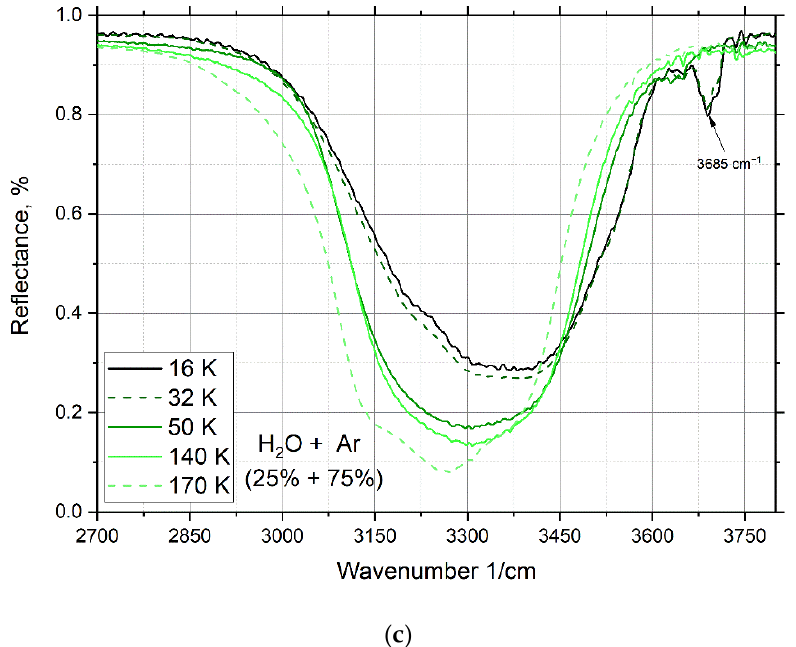
Figure 8. IR spectra of water and argon mixture deposited by PVD method: ( а ) from 1000 to 1400 cm −1 ; ( b ) from 2000 to 2400 cm −1 ; ( с ) from 2700 to 3750 cm −1 .